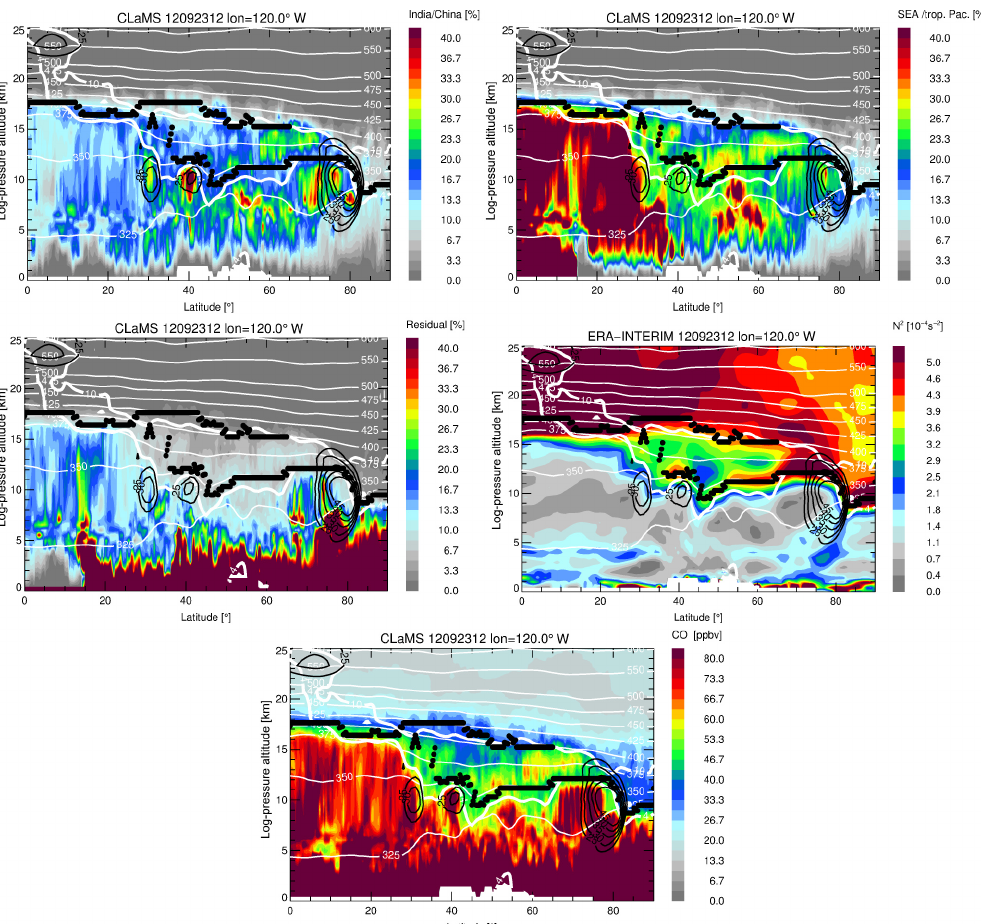
Figure 6. Latitude–height cross sections of the Northern Hemisphere at 120 ◦ W longitude on 23 September 2012 including a northward- directed filament of low PV ( ≈ 35–80 ◦ N) moving along the subtropical jet for the fraction of air originating in India/China (top left), the fraction of air originating in southeast Asia/tropical Pacific Ocean (top right), the fraction of air originating in the residual surface (bottom left), and buoyancy frequency squared N 2 (bottom right). The climatological isentropic transport barriers of 4 and 10PVU at 350 and 400K, respectively, for September (thick white lines) and thermal tropopause (black dots) are shown. The corresponding levels of potential temperature are marked by thin white